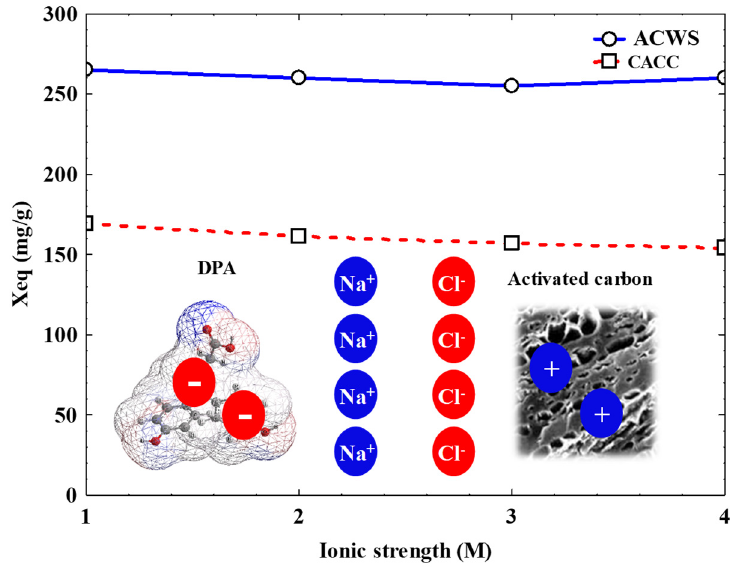
) and CACC ( (cid:3) ) at